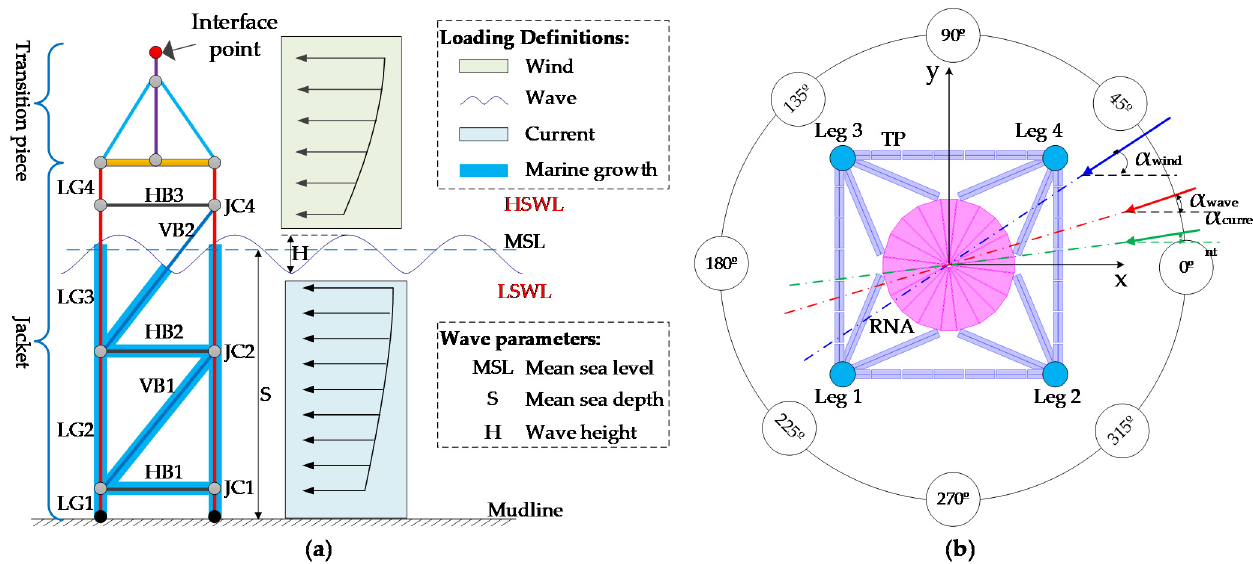
Figure 3. Environmental loads acting on the jacket substructure: ( a ) Loading representation; ( b ) Definition of environmental loading directionality.